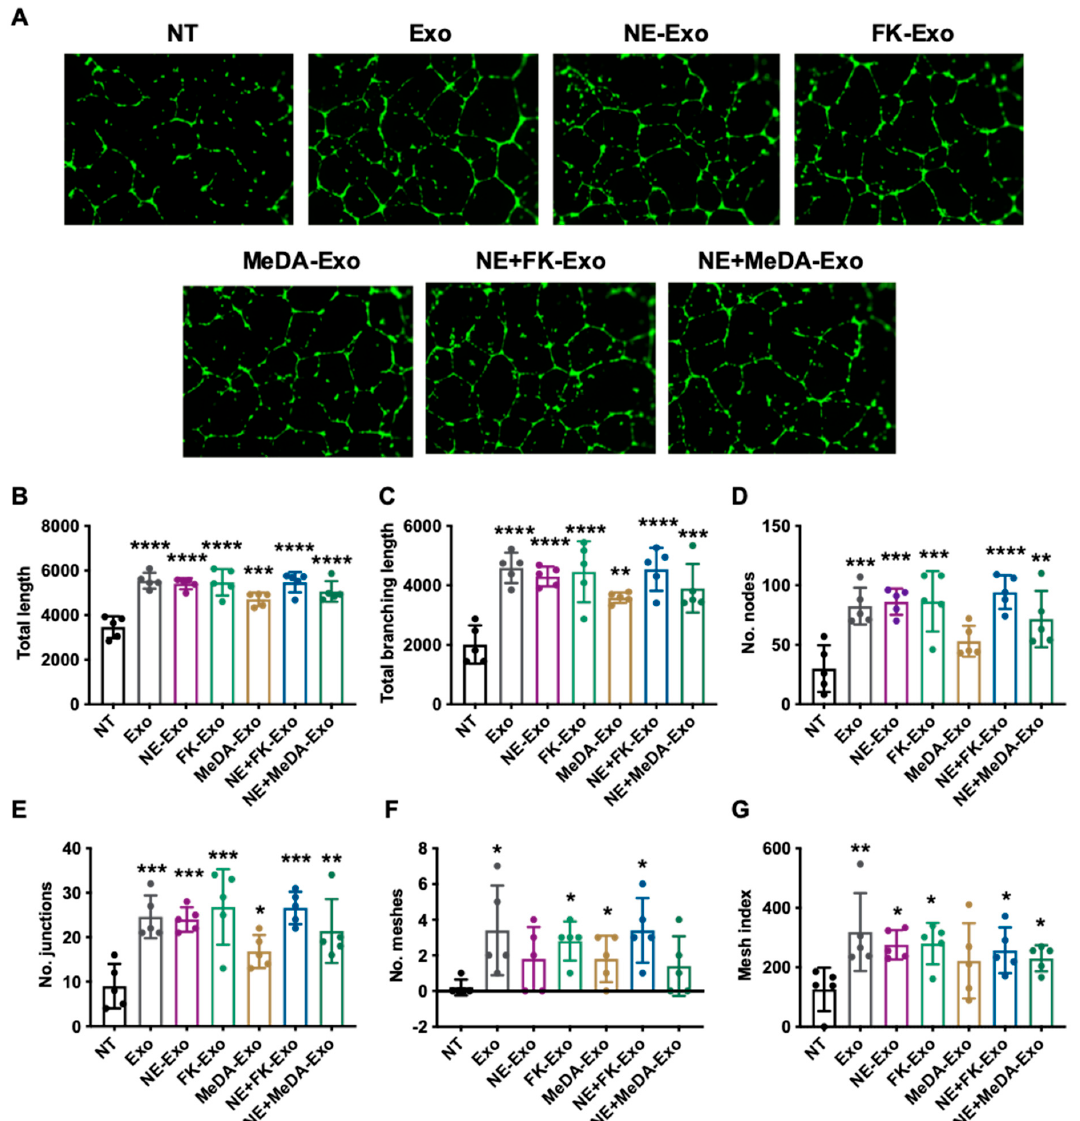
Figure 4. Tube formation assay. ( A ) Representative images of the angiogenesis effect of compound- treated MSC-derived exosomes. ( B – G ) Quantification of angiogenesis using ImageJ. ( B ) Total length. ( C ) Total branching length. ( D ) The number of nodes. ( E ) The number of junctions. ( F ) The number of meshes. ( G ) The mesh index. One-way ANOVA with Dunnett’s multiple comparisons test, * p < 0.05, ** p < 0.01, *** p < 0.001, **** p < 0.0001; n = 5.